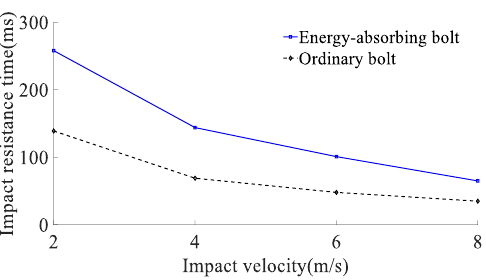
Figure 12. Anchor energy absorption – displacement curve.